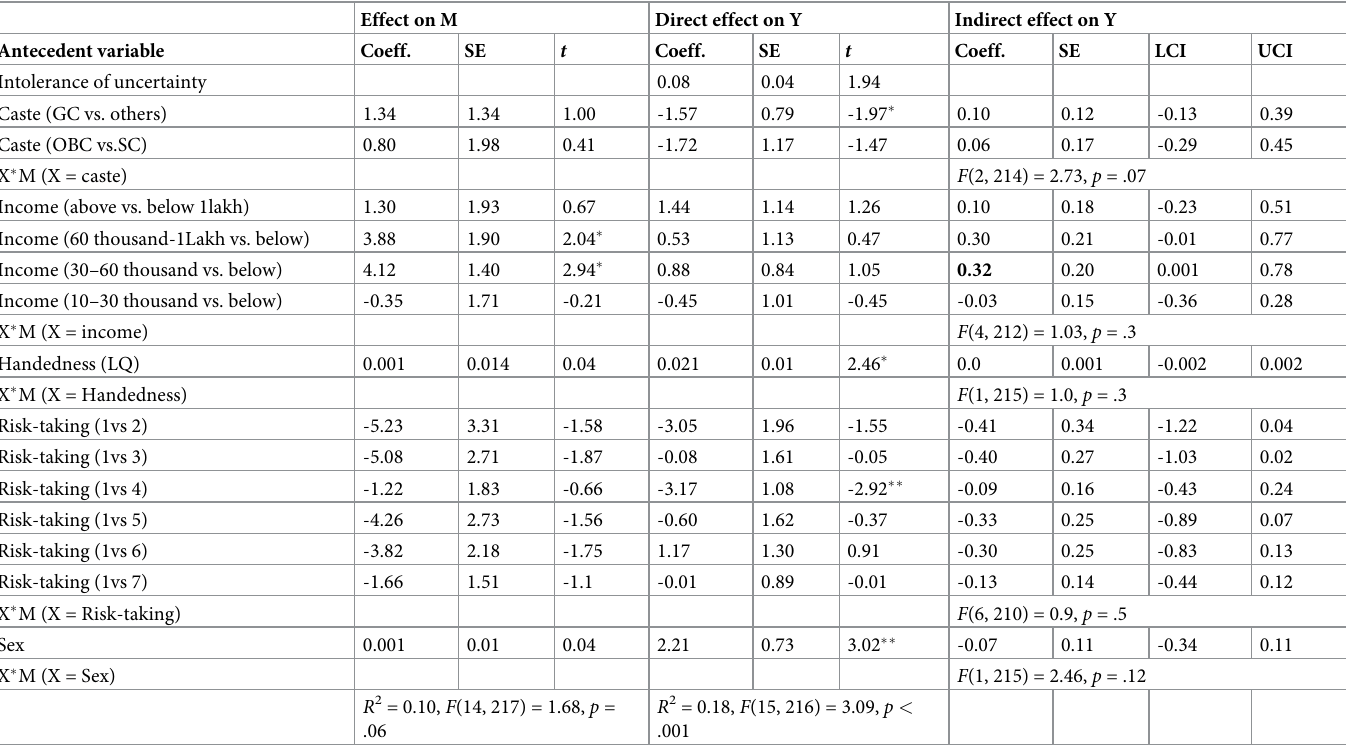
Table 15. The effects (direct and indirect effect) of antecedent and mediation (general IU) variables on behaving in the community